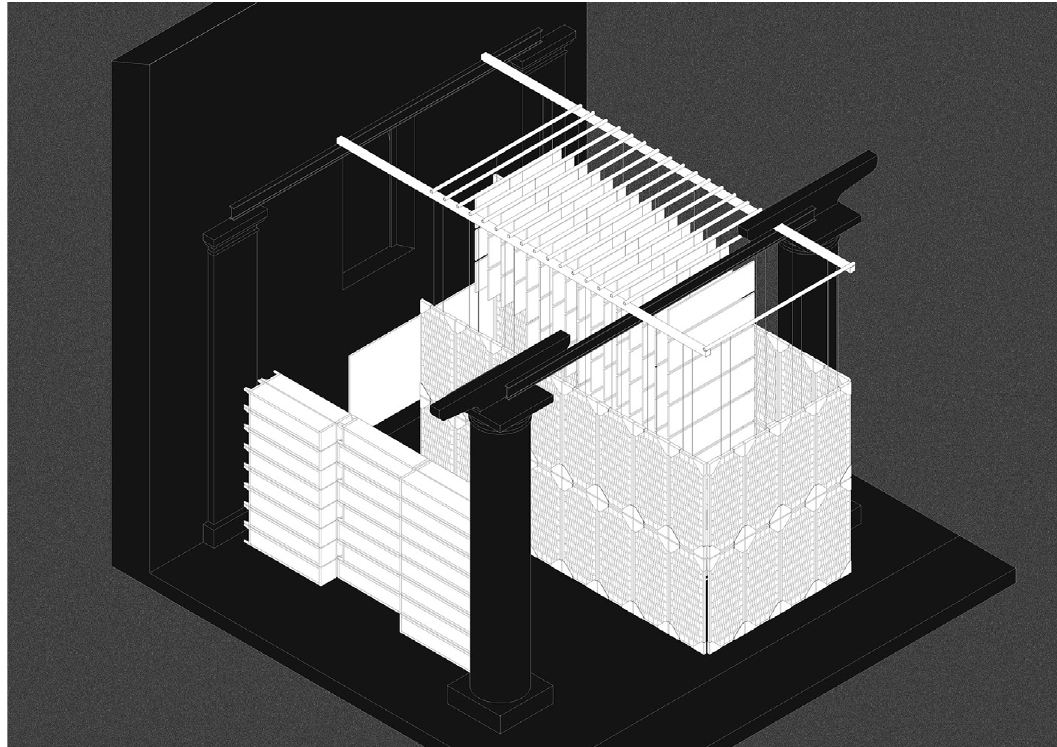
Figure 6. Furniture materials assembled to create Rural Studio’s “Theater of the UseFULL” at the Corderie dell’Arsenale in 2016